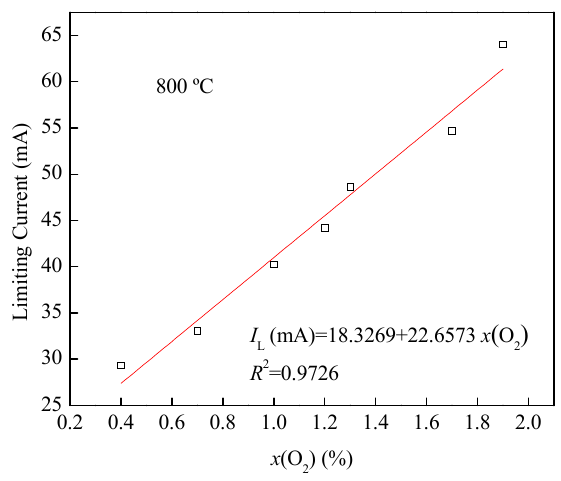
Figure 8. Limiting current and the oxygen concentration at the temperature of 800 °C.